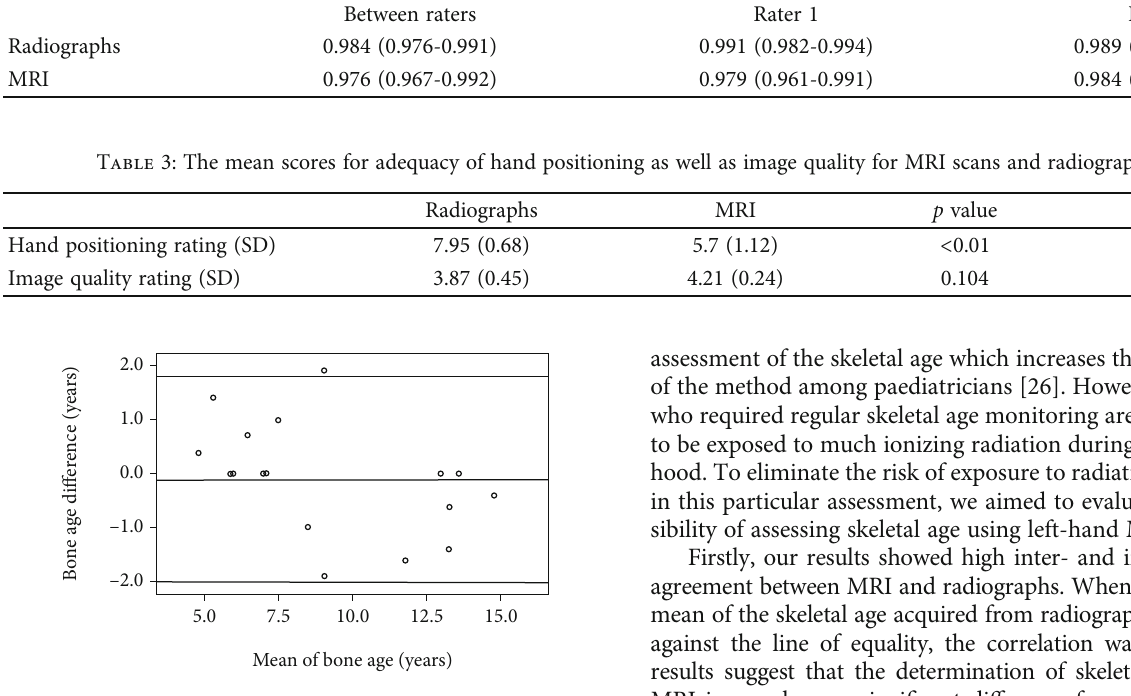
Figure 1: The variation between MRI and radiograph reading for Rater 1 using Bland Altman plot.